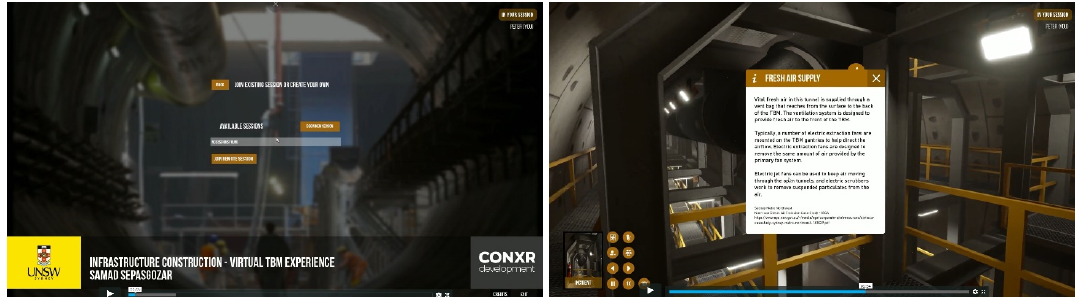
Figure 10. Screenshots from the login page ( left ), and one of the information hot spots on the VTBM ( right ). Several hotspots were embedded into the VTBM, referring to some interesting learning points in different parts of the module.